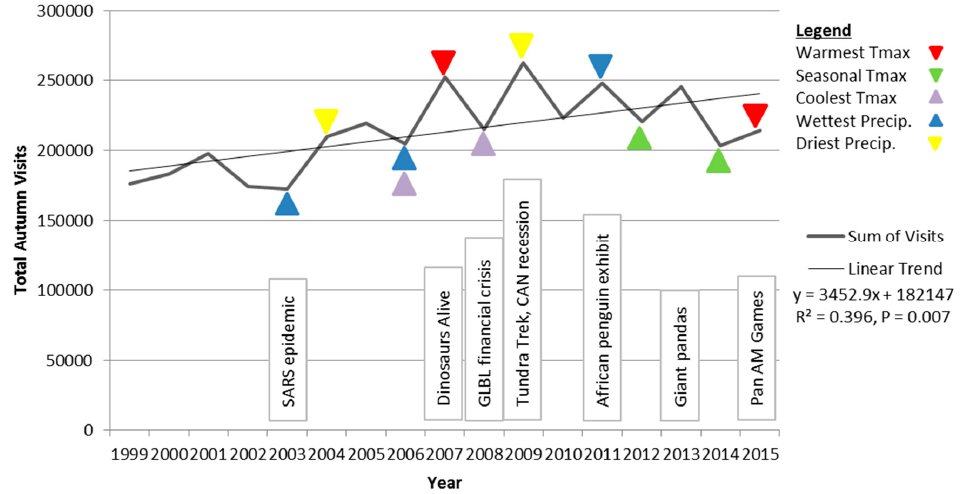
Figure 5. Total zoo visitation by year for the autumn season, indicating climatic anomalies, climate normals, and other non-climatic factors from 1999 to 2015.